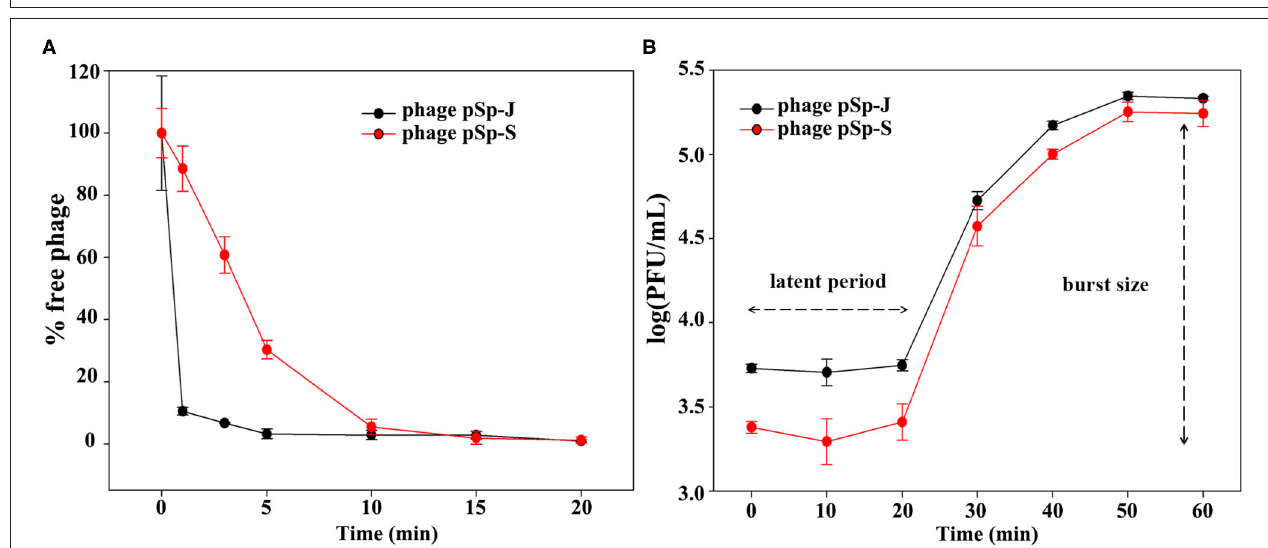
FIGURE 2 | Biological characteristics of pSp-J and pSp-S. (A) Adsorption assays and (B) one-step growth curve of pSp-J and pSp-S with methicillin resistant S. pseudintermedius indicator strain C21-2-1. Values are presented as the mean ± standard deviation.